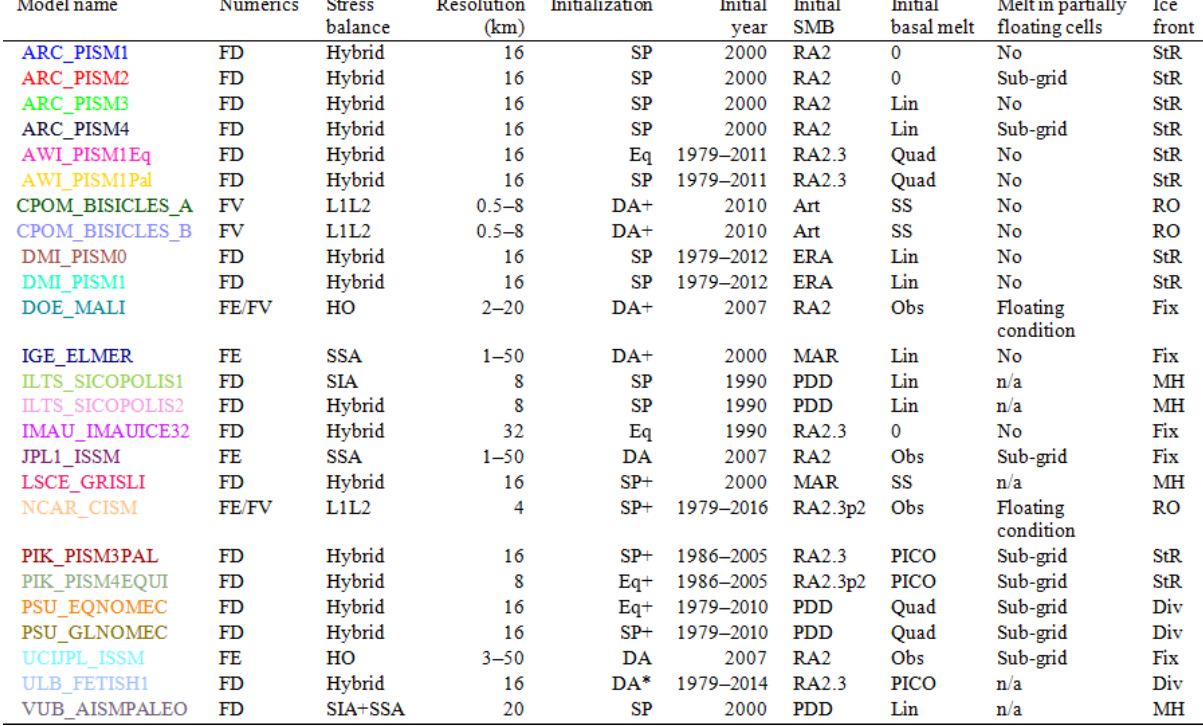
Table 2. List of initMIP-Antarctica simulations and main model characteristics. Numerics rely on the finite-difference (FD), finite-element (FE), or finite-volume (FV) method. Initialization methods are as follows: spin-up (SP), spin-up with target values for the ice thickness (SP + ; see Pollard and DeConto, 2012a), data assimilation (DA), data assimilation with short relaxation (DA + ), data assimilation of ice geometry (DA ∗ ), equilibrium state (Eq), and equilibrium state with target values for the ice thickness (Eq + ). Initial SMB is derived from the following: RACMO2 (RA2; Lenaerts et al., 2012), RACMO2.3 (RA2.3; van Wessem et al., 2014), RACMO2.3p2 (RA2.3p2; van Wessem et al., 2018), MAR (Agosta et al., 2019), ERA Interim (ERA; Dee et al., 2011), Arthern et al. (2006) (Art), and positive degree-day schemes (PDD; Reeh, 1991). Basal melt rates are based on zero melting (0), linear function of thermal forcing (Lin; Martin et al., 2011), quadratic function of thermal forcing (Quad; DeConto and Pollard, 2016), melt rates estimated from observations (Obs; Rignot et al., 2013; Depoorter et al., 2013), ice shelf thickness target (SS), ice shelf thickness target with no refreezing (SS ∗ ), and the PICO parameterization (Reese et al., 2018). Models that have partially floating cells at the grounding line apply melting using a sub-grid scheme (Sub-grid), a floatation condition to assess if melt should be applied over the entire cell or not (Floating condition), or no melt at all (No) in their partially floating cells. Ice front migration schemes are primarily based on strain rate (StR; Levermann et al., 2012), retreat only (RO), fixed front (Fix), minimum thickness height (MH), and divergence and accumulated damage (Div; Pollard et al., 2015). The DMI_PISM1 and DMI_PISM0 differ by the basal melt applied under the floating ice, with a basal melt reduced by an order of magnitude in DMI_PISM1 compared to DMI_PISM0. Further details on all the models are given in Appendix